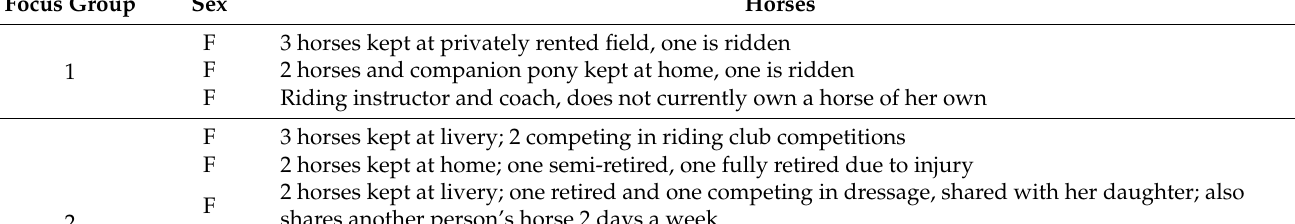
Table 1. Focus group participant details, including a summary of horse owning experience.